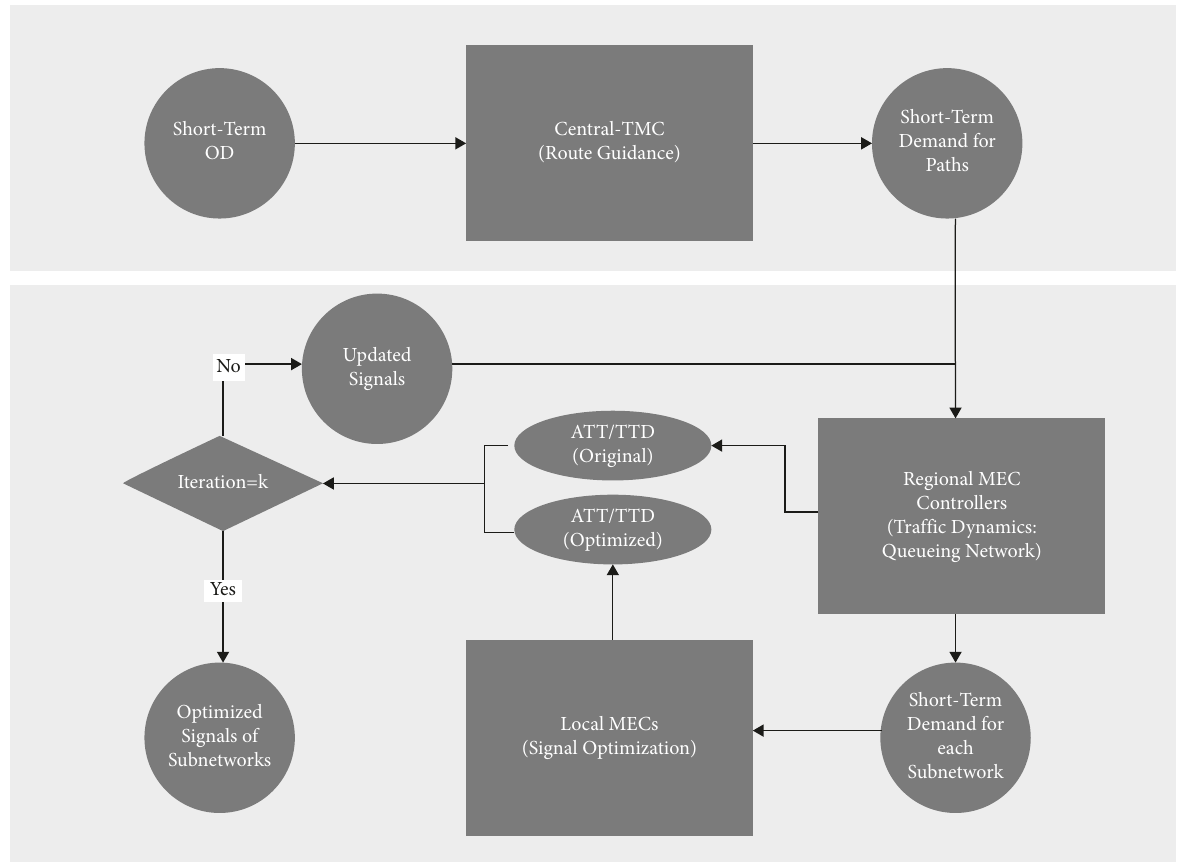
Figure 8: Two-layer process for decentralized signal control